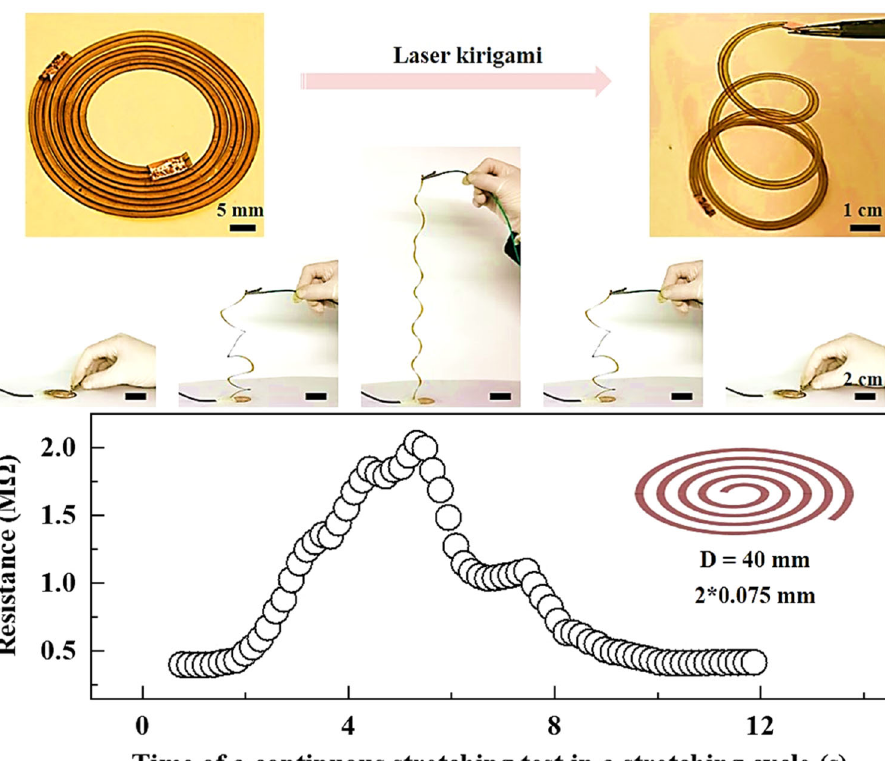
Fig. 3 Stretching test of the 3D graphene-based spiral sensor. It shows that the 3D graphene-based spiral sensor prepared by stretching the 2D graphene-based spiral sensor fabricated by laser kirigami. The resistance changes with the time of a continuous stretching test in a stretching cycle. The maximum stretching height reaches 21 cm. Laser speed 1%, power 0.3%, PPI